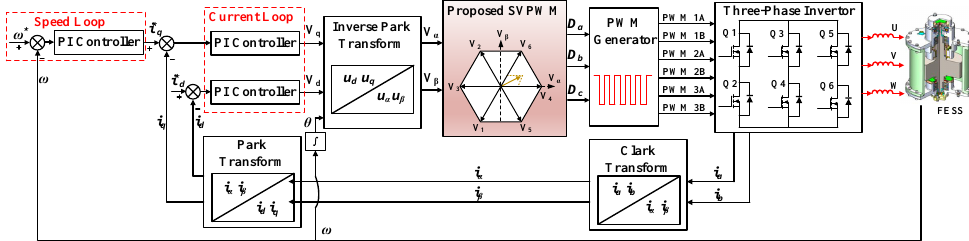
Figure 14. The block diagram of the proposed SVPWM algorithm implemented in PMSM